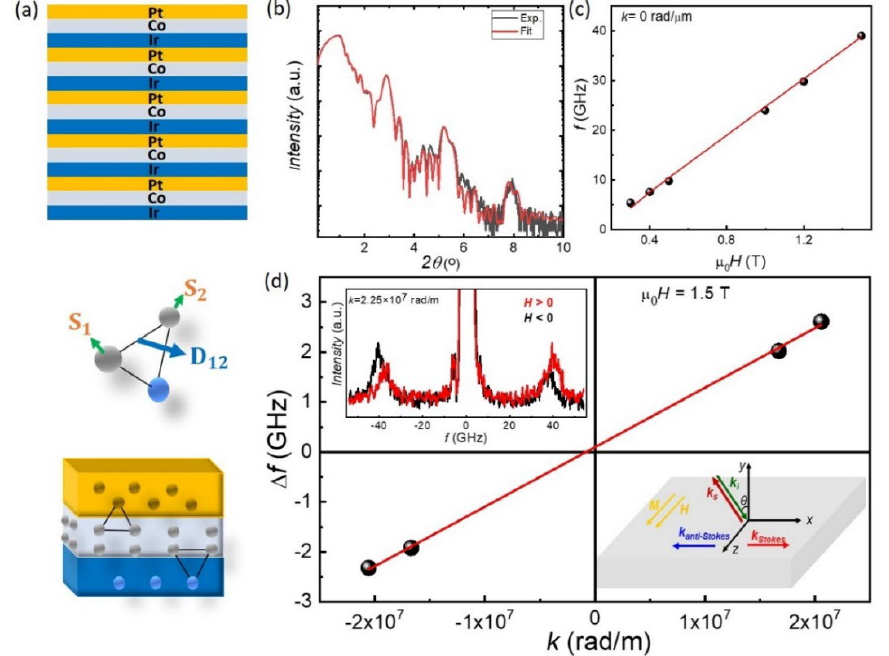
Figure 1. Structural and interfacial characterisation of [Ir/Co/Pt] 5 multilayers for t Co = 0.8 nm at room temperature. ( a ) Schematic diagrams of the multilayer film structure and the corresponding interfacial DMI produced between S 1 and S 2 spins of two adjacent Co atoms located close to the Ir or Pt atoms with a strong SOC. ( b ) XRR measurement result: intensity as a function of 2 θ incident angle. ( c , d ) BLS measurements. ( c ) Dependence of the spin wave (SW) frequency ( f ) as a function of the intensity of the in-plane applied field, µ 0 H , as measured at normal incidence for k = 0 rad/ µ m. ( d ) SW frequency asymmetry, ∆ f , measured at k = 1.67 × 10 7 rad/m and k = 2.25 × 10 7 rad/m when reversing the direction of the applied magnetic field, which is equivalent to the reversal of the propagation direction of the DE mode. Top inset: BLS spectra measured at k = 2.25 × 10 7 rad/m. Bottom inset: Schematic of BLS experiment. The sample is saturated in-plane by an external field, µ 0 H = 1.5 T, applied along the z-axis. Stokes and anti-Stokes events in the scattering process correspond to SW propagating with +k and − k, respectively.